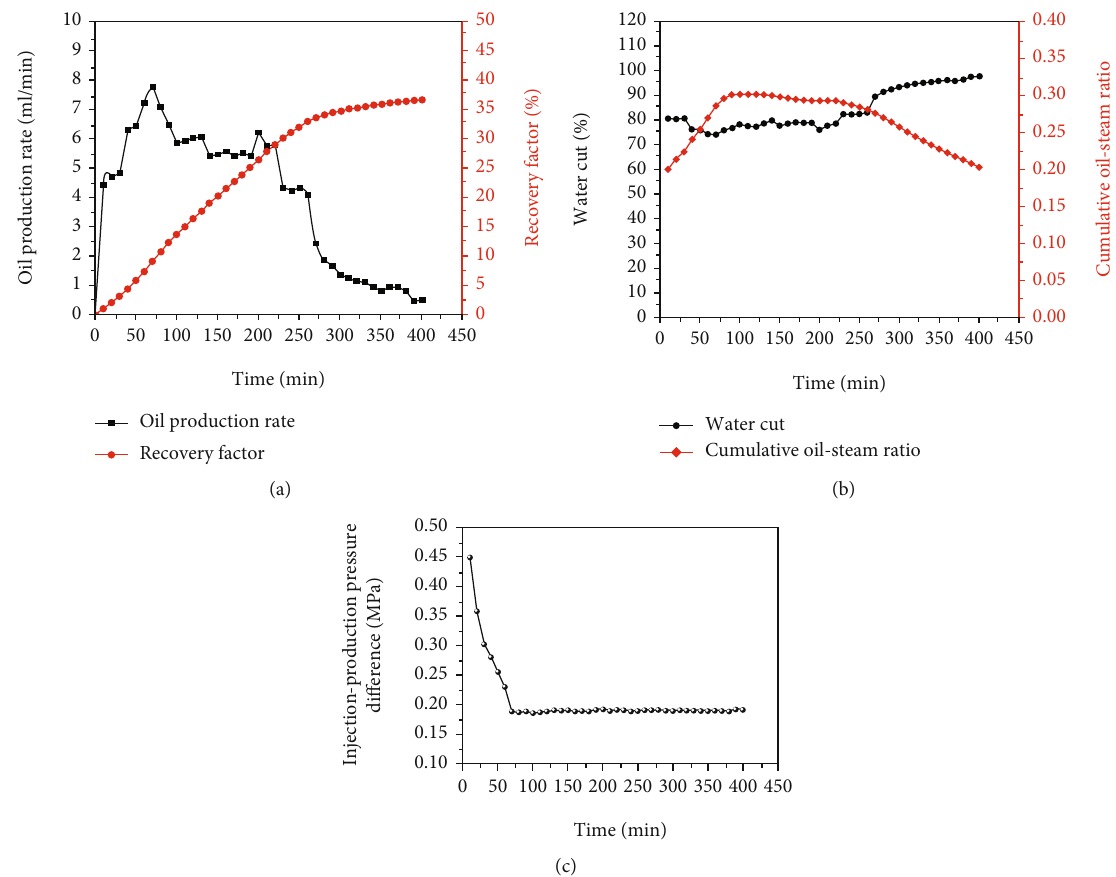
Figure 17: Production performance of 3D dislocated well SAGD experiment. (a) Change of oil production rate with time and recovery factor with time. (b) Change of water cut with time and cumulative oil-steam ratio with time. (c) Change of injection-production pressure di ff erence with